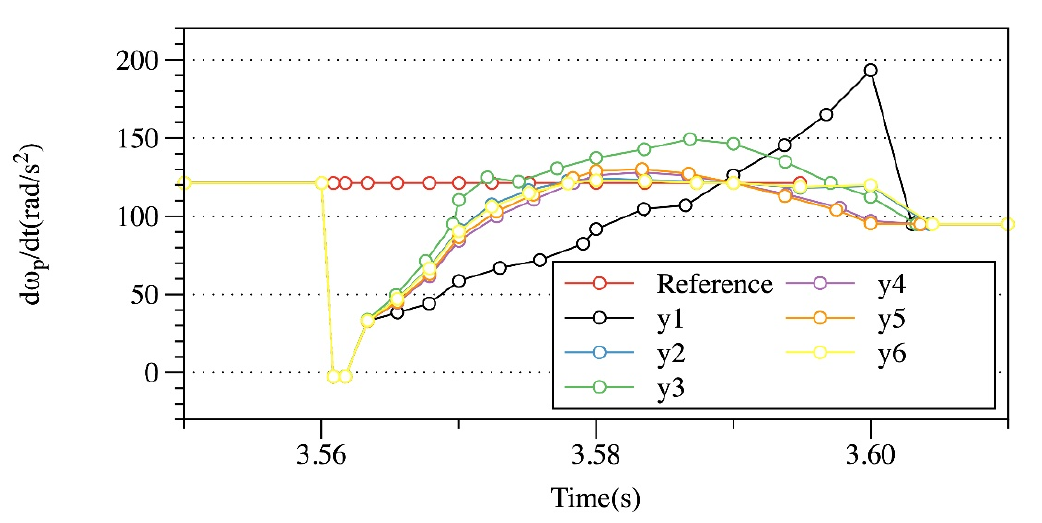
Figure 15. Torque gap filling performance analysis.